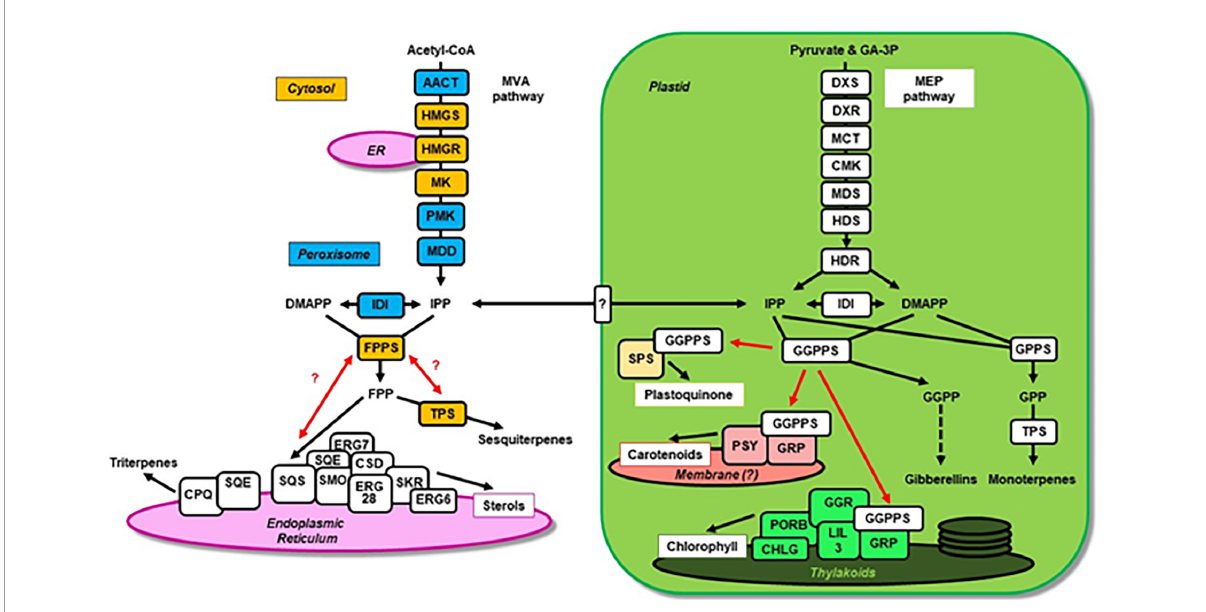
FIGURE1 The plant terpenoid metabolic network and potential metabolons involved in the biosynthesis of specific compounds. The plastid and endoplasmic reticulum are highlighted in green and purple, respectively. The MVA pathway enzymes localized in peroxisomes and the cytosol are labeled in blue and orange, respectively. Individual enzymes are depicted as boxes and black arrows indicate metabolic fluxes. Confirmed and putative (with question mark) interactions of prenyltransferases with downstream enzymes forming metabolons are indicated by red arrows. The unknown transporter involved in IPP and DMAPP exchange between cytosol and plastid is shown in the plastid envelope membrane. Abbreviations: AACT, aceto-acetyl-CoA thiolase; CHLG, chlorophyll synthase; CMK, 4-(cytidine 5-diphospho)-2-C-methyl-D-erythritol kinase; CPQ, cucurbitadienol synthase; CSD, sterol C-3 dehydrogenase/C-4 decarboxylase; DMAPP, dimethylallyl diphosphate; DXR, 1-deoxy-D-xylulose 5-phosphate reductoisomerase; DXS, 1-deoxy-D-xylulose 5-phosphate synthase; FPPS, farnesyl diphosphate synthase; GA-3P, D-glyceraldehyde 3-phosphate; GGPPS, geranylgeranyl diphosphate synthase; GGR, geranylgeranyl reductase; GPPS, geranyl diphosphate synthase; GRP, GGPPS recruiting protein; HDR, ( E )-4-hydroxy-3-methylbut-2-enyl diphosphate reductase; HDS, ( E )-4-hydroxy-3-methylbut-2-enyl diphosphate synthase; HMGR, 3-hydroxy-3-methylglutaryl-CoA reductase; HMGS, 3-hydroxy-3-methylglutaryl-CoA synthase; IDI, isopentenyl diphosphate isomerase; IPP, isopentenyl diphosphate; LIL3; light-harvesting-like protein 3; MCT, 2-C-methyl-D-erythritol 4-phosphate cytidylyltransferase; MDD, mevalonate diphosphate decarboxylase; MDS, 2-C-methyl-D-erythritol 2,4-cyclodiphosphate synthase; MK, mevalonate kinase; PMK, phosphomevalonate kinase; PORB,